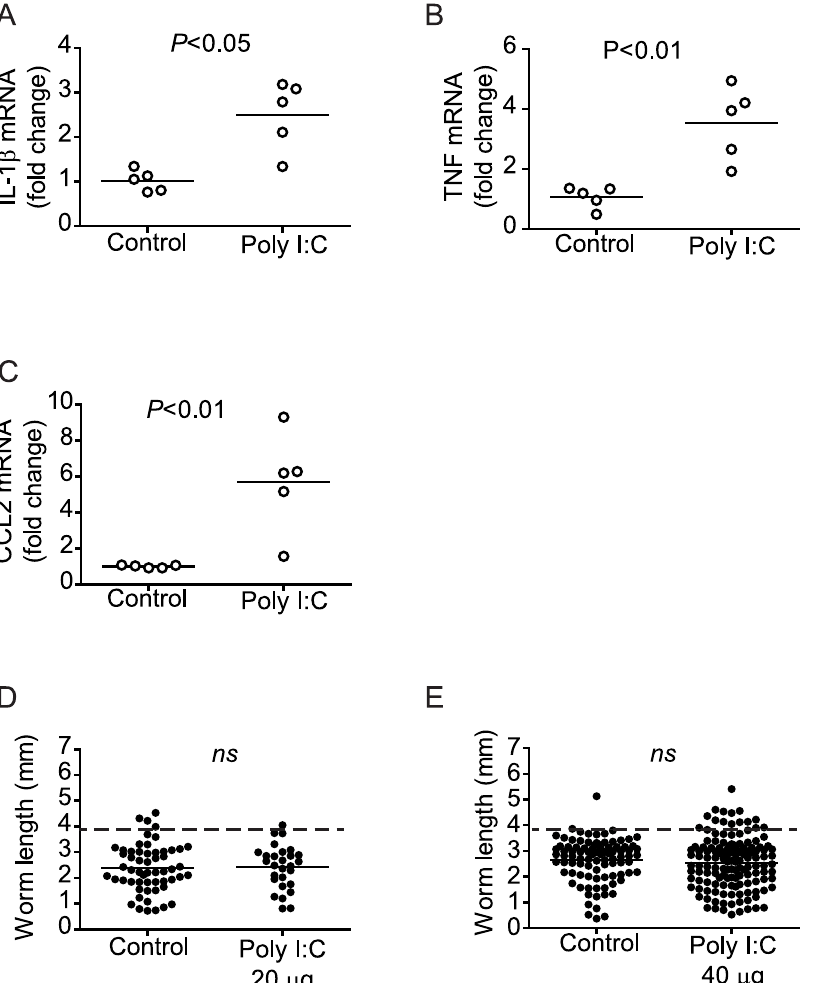
Figure 5. Chronic poly I:C administration does not restore regulation of pro-inflammatory cytokine transcription or parasite development in infected RAG 2 / 2 mice. Groups of S. mansoni -infected RAG 2 / 2 mice were repeatedly treated throughout pre-patent infection with poly I:C, as described in Materials and Methods. At 6 weeks p.i., mice were euthanized, parasites perfused from the portal tract and spleens removed for analysis of IL-1 b (A), TNF (B) and CCL2 (C) mRNA content by real-time PCR. (D and E) Length of male worms recovered from RAG 2 / 2 mice treated repeatedly with 20 m g (D) or 40 m g (E) doses of poly I:C. Horizontal bars represent mean values for each experimental group. P values were calculated using the Mann Whitney test and student’s T-test with Welch’s correction. Dashed lines in D and E indicate the average length of male S. mansoni worms recovered from wild type mice at day 42 post infection (3.9 mm).